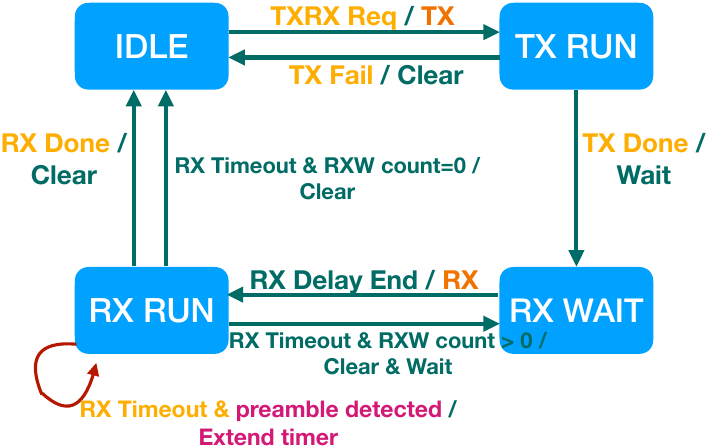
Figure 7. The modified LPHY FSM for the RXW prolonging scheme.